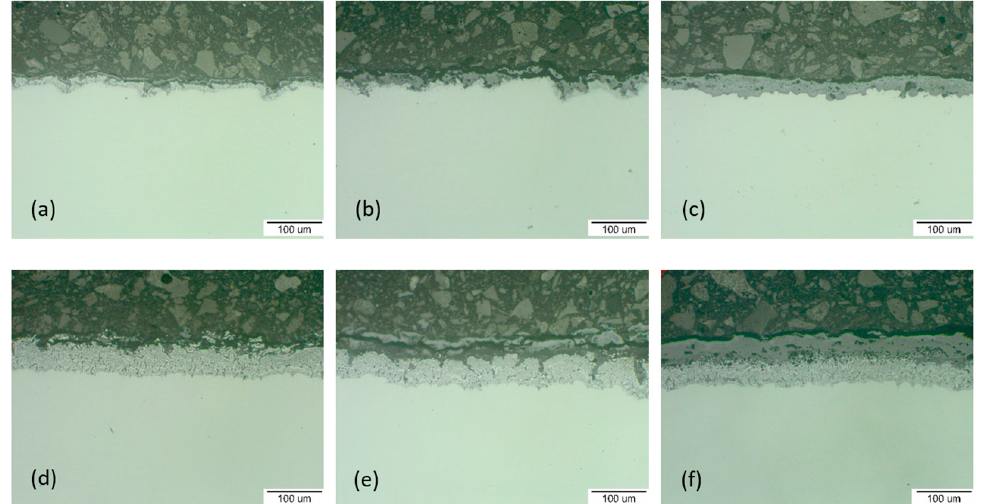
Figure 2. P91 cross-section analysis for: ( a ) 100 h; thickness of the oxide layer 18.97 µ m, ( b ) 1000 h; 23.05 µ m, ( c ) 3000 h; 49.37 µ m and MarBN for: ( d ) 100 h; 20.64 µ m, ( e ) 1000 h; 26.93 µ m ( f ) 3000 h; 57.91 µ m oxidized at 600 ◦